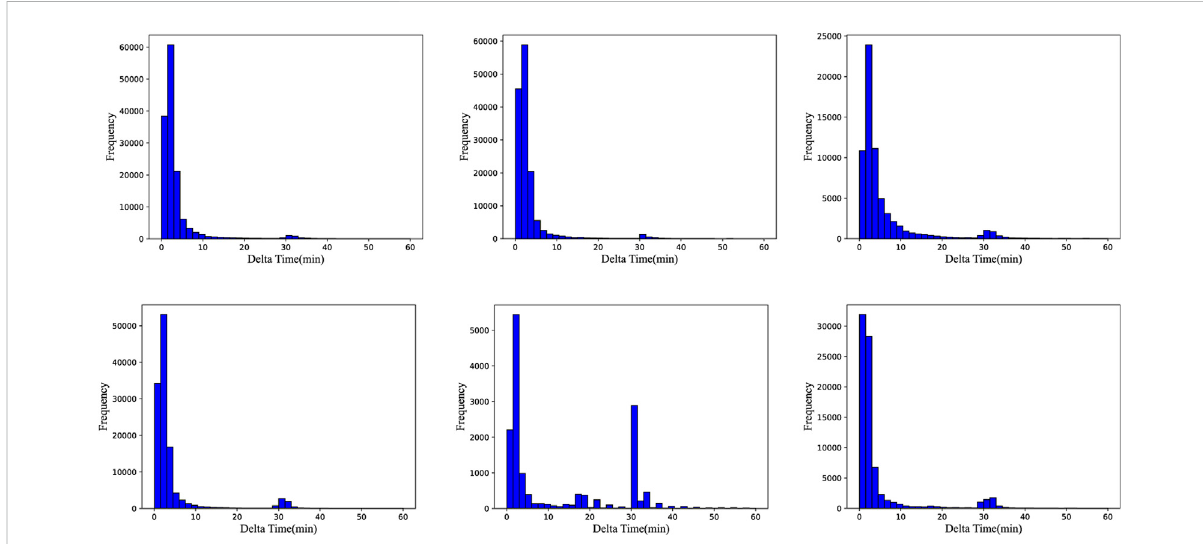
FIGURE 5 Trajectory data distribution. The abscissa indicates the time interval between two adjacent trajectory points on the trajectory sequence; the ordinate indicates the frequency of